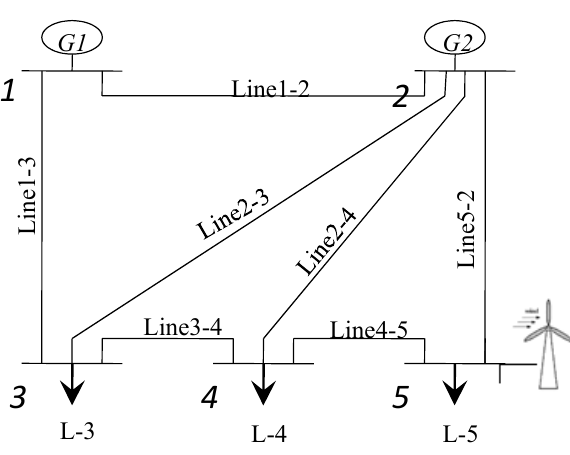
Figure 5. Single line diagram of the five-bus network with a wind farm.